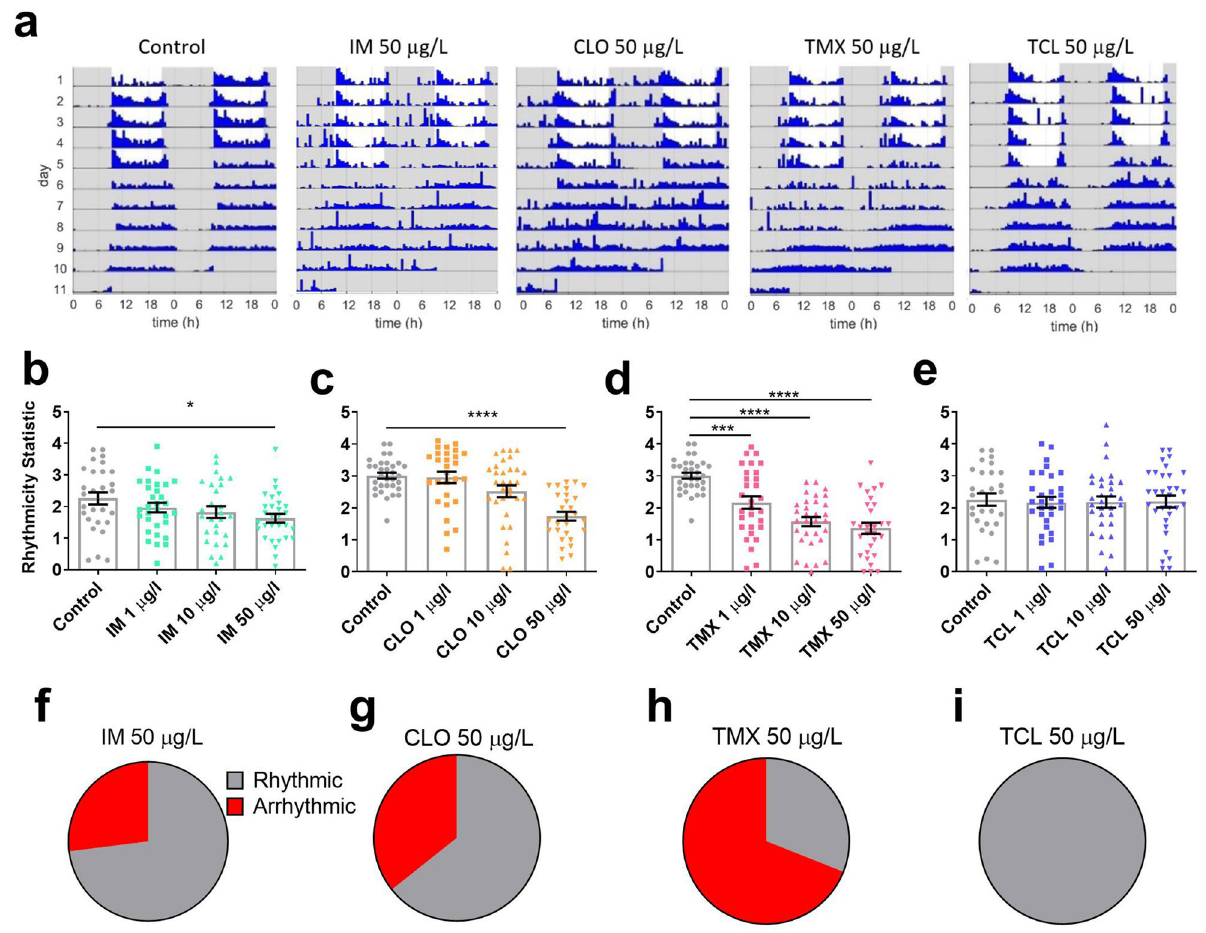
Figure 2. Field relevant concentrations of neonicotinoids reduced behavioural rhythmicity. ( a ) Representative actograms of the activity of single flies for control or 50 μg/L imidacloprid, clothianidin, thiamethoxam or thiacloprid. Blue bars indicate activity, grey background indicates lights off, white background lights on. Mean rhythmicity for flies exposed to 1, 10 or 50 μg/L ( b ) IM ( F 3,112 = 2.5, p = 0.060), ( c ) CLO ( F 3,116 = 14.2, p < 0.001), ( d ) TMX ( F 3,118 = 23.7, p < 0.001) and ( e ) TCL ( F 3,118 = 0.05, p = 0.987). Each data point represents a single fly, n = 28–32 flies per treatment. Pie charts show the increase in the proportion of the population who were arrhythmic (rhythmicity statistic (RS) ≤ 1.5) for 50 μg/L: ( f ) IM, ( g ) CLO, ( h ) TMX and ( i ) TCL, compared to